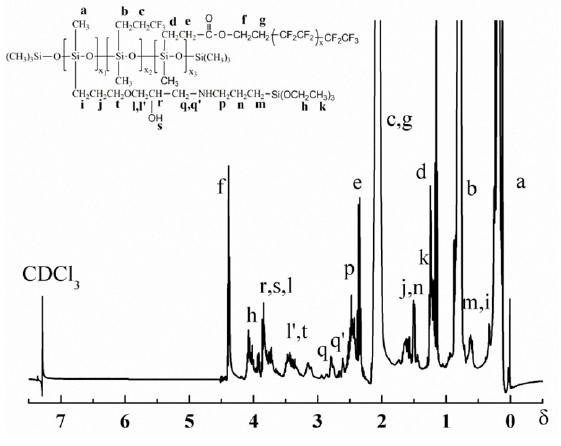
Figure 2. 1 H ‐ NMR of the PFAS.